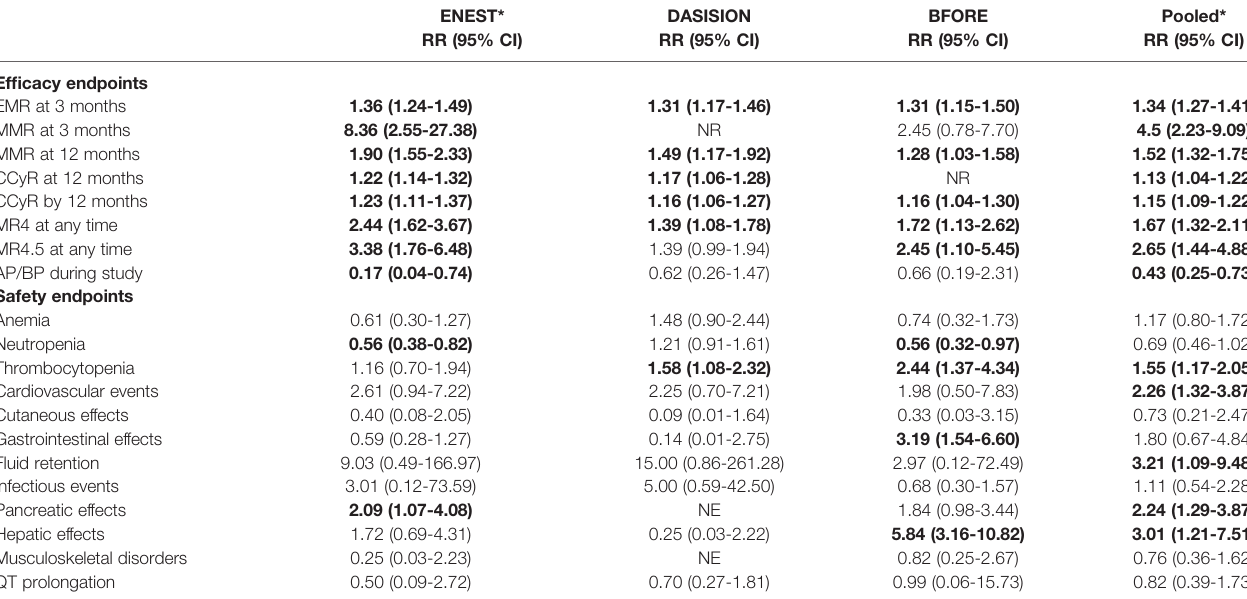
TABLE 1 | Relative risk of later-generation TKIs in comparison with imatinib by ef fi cacy and safety endpoints. ENEST*